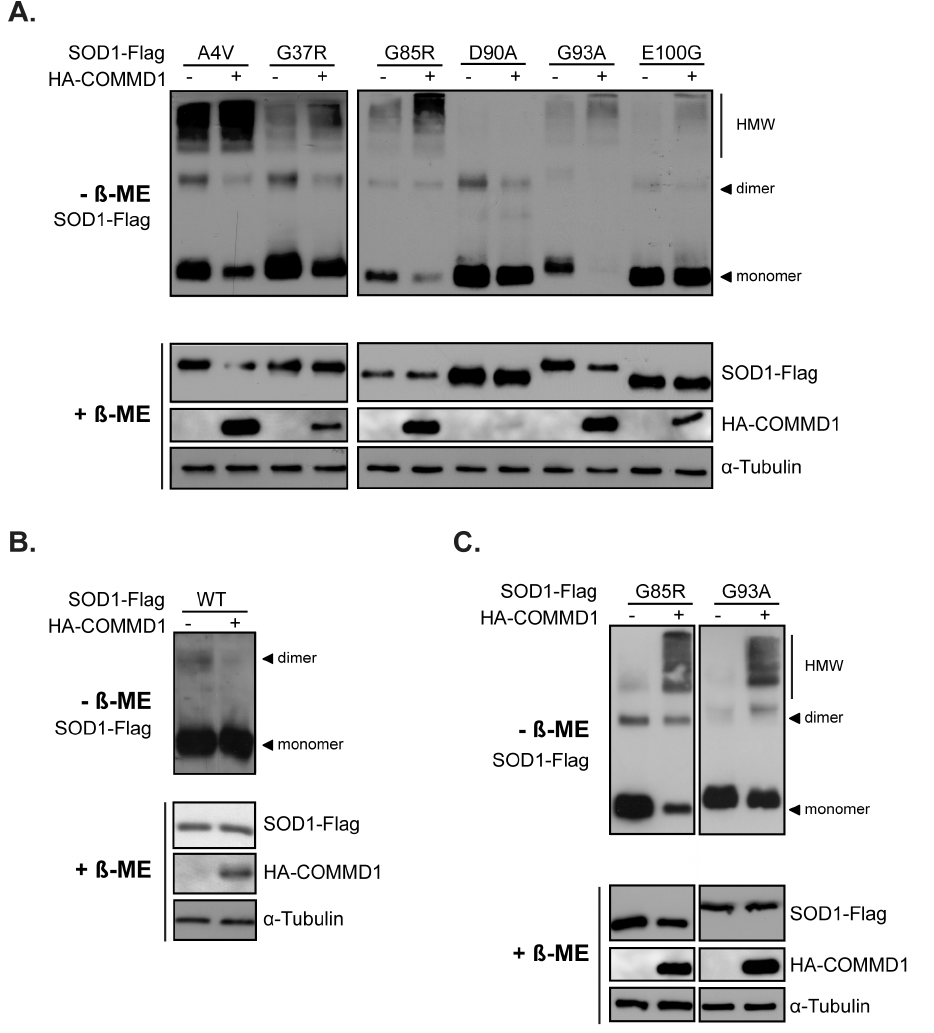
Figure 3. Formation of mSOD1 high molecular mass species is regulated by COMMD1. A. HEK293T cells were co-transfected with SOD1- Flag mutants (A4V, G37R, G85R, D90A, G93A, E100G) in combination with EV (–) or HA-COMMD1 prior to lysis and detection of SOD1 multimeric complexes using SDS-PAGE under non-reducing conditions (– b -ME; 40 m g). Immunoblotting was performed using antibodies directed against the Flag-tag and HA-COMMD1 proteins. Input samples were analysed in presence of b -ME ( + b -ME; 30 m g). Samples were analysed on separated membranes. B. HEK293T cells were co-transfected with SOD1-Flag WT in combination with EV (–) or HA-COMMD1 prior to lysis and analysed as described in Figure 3A. C. Visualization of SOD1 HMW complexes in Neuro2A cells transfected with SOD1-Flag mutants G85R and G93A